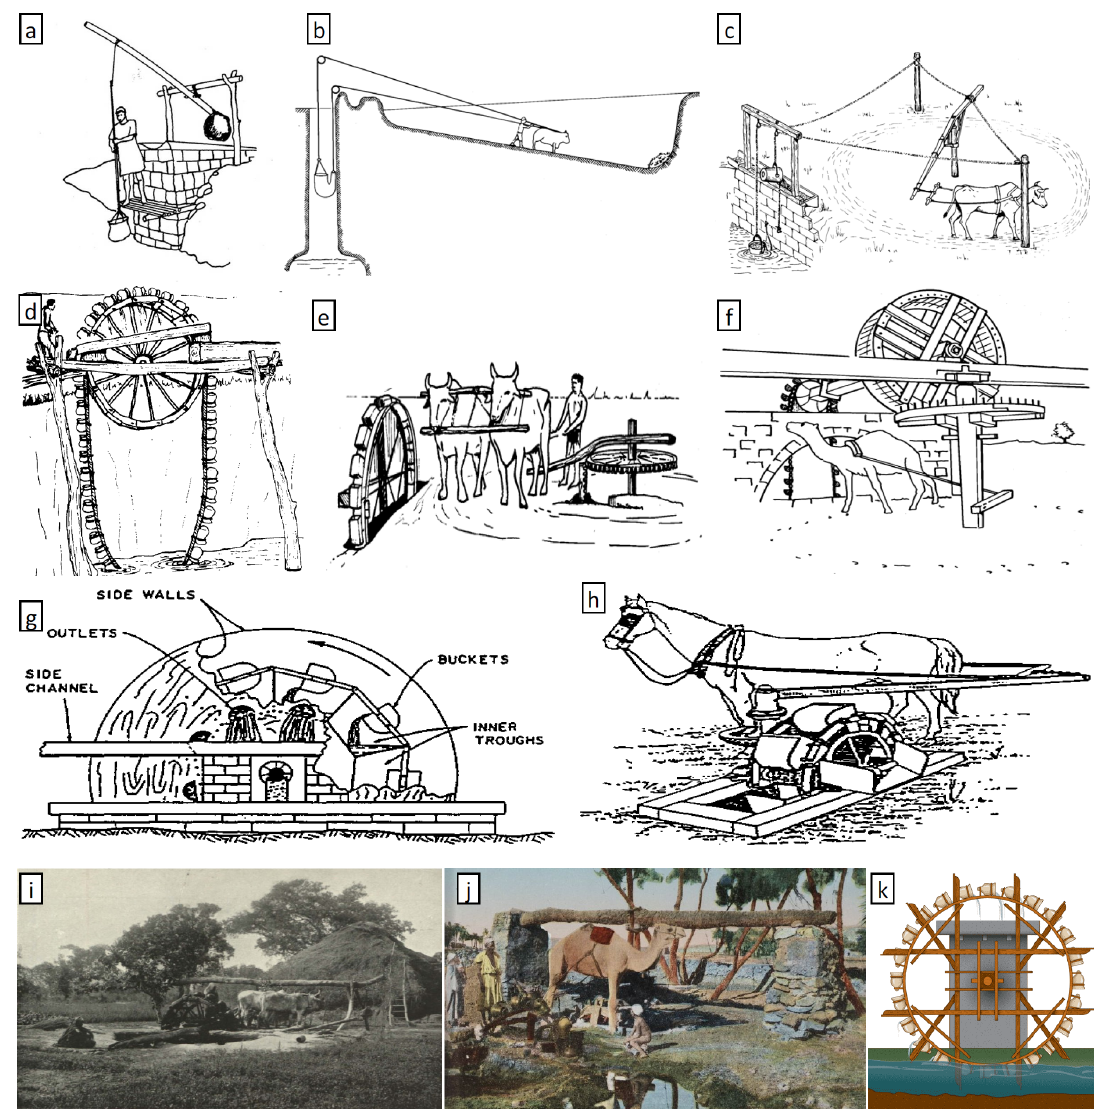
Figure 5. Traditional water lifting devices in ancient Persia, ( a ) Persian shaduf; ( b ) cross-section view of a mohte; ( c ) circular mohte utilizing two buckets with flap-valves in bottom; ( d ) Persian waterwheel; ( e ) a bullock-driven Persian waterwheel of the conventional chain and bucket type; ( f ) camel-driven Persian waterwheel showing over-head drive mechanism; ( g ) modified Persian waterwheel or zawafa; ( h ) zawafa by horse power; ( i ) improved Persian waterwheel or sakkia; ( j ) sakkia by camel power; ( k ) Persian Noria (adapted from